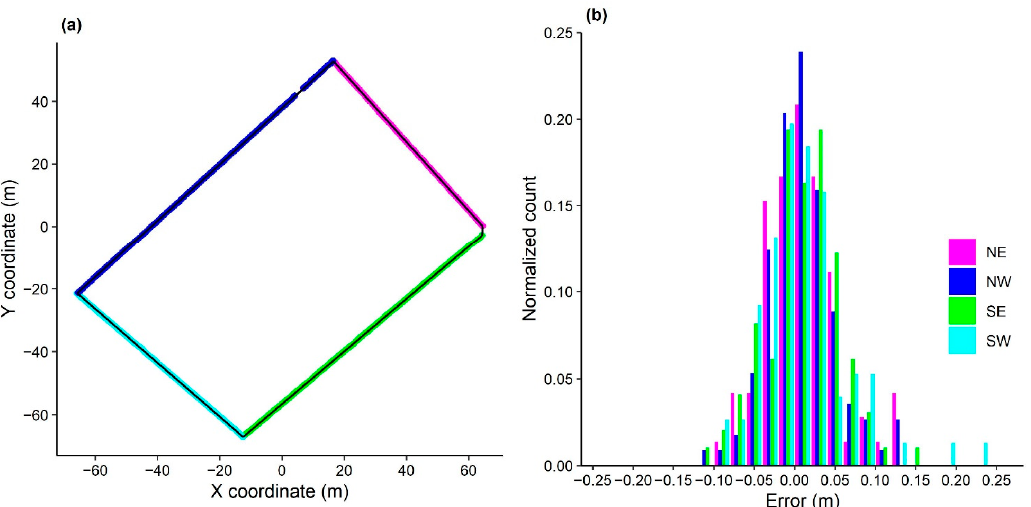
Figure 8. Graphs of ( a ) the fence line coordinates based on GNSS positional data with an optimally fit line (black line) and the GNSS positional points (coloured lines), and ( b ) the measurement errors of each fence line (north–east, north-west, south-east, and south-west). Note: To normalise the count, the frequency of observations in each bin was divided by the total number of observations.